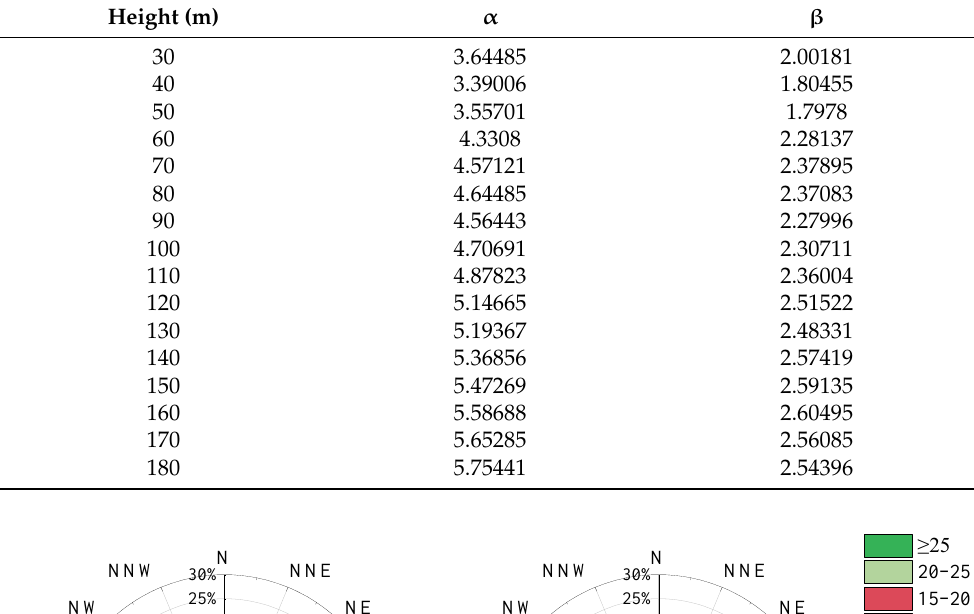
Table 4. Parameters of the Weibull distribution model at different heights.